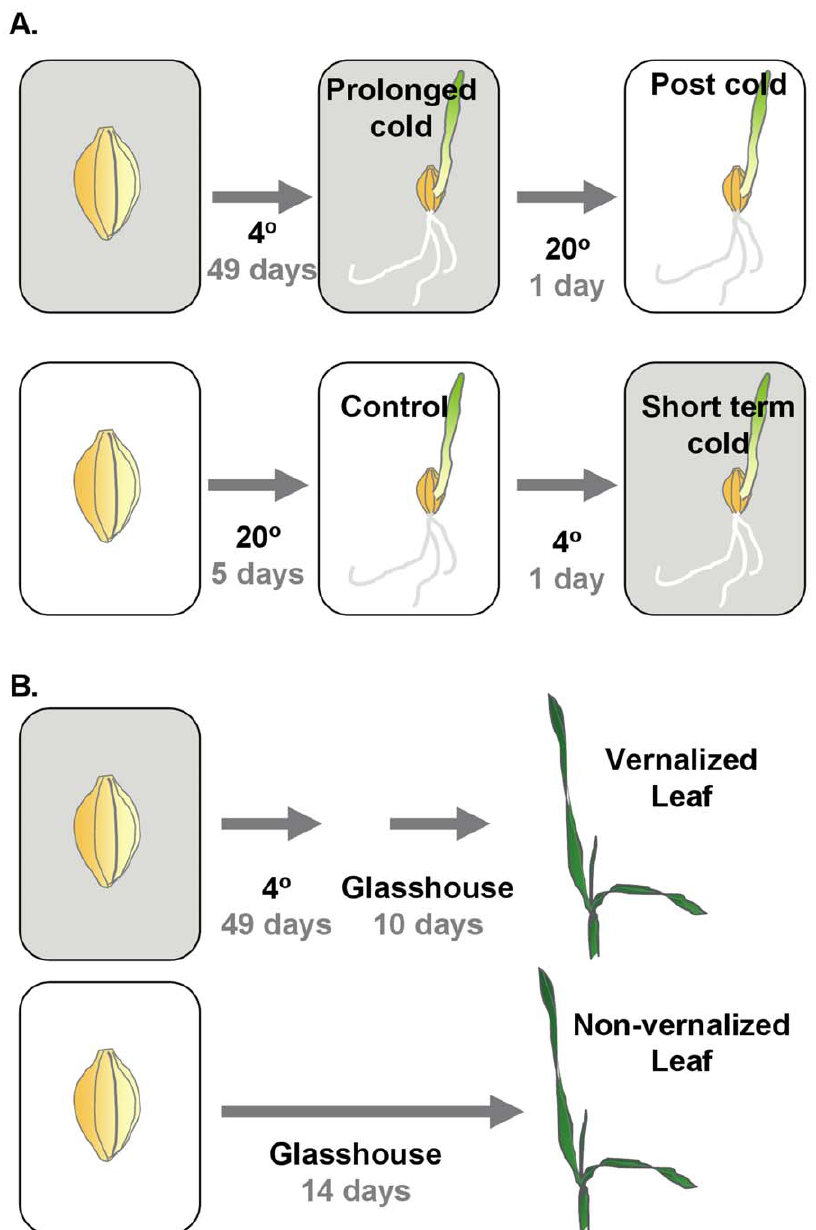
Figure 1. Overview of sampling methods for microarray analysis. A) Barley seeds (cv. Sonja) were germinated and grown in darkness at either 20 u C over 5 days (control) or 4 u C over 49 days (prolonged cold). Seedlings were then shifted from the control treatment to 4 u C for 24 hours (short term cold) or shifted from the prolonged cold treatment to 20 u C for 24 hours (post cold). In all treatments the shoot apex remained at an early stage of vegetative development, but plants grown from seedlings that experienced prolonged cold flower rapidly when shifted to normal growth conditions, unlike control seedlings germinated at 20 u C [20]. B) To identify contigs that show a sustained response to prolonged cold, barley seeds were germinated in the dark at 4 u C for 49 days and then transferred to growth in glasshouse conditions until they reached the three leaf stage (10 days after the end of cold treatment). Non-vernalized control plants were grown simultaneously under the same conditions and were sampled at the equivalent developmental leaf stage (14 days). Grey shading indicates